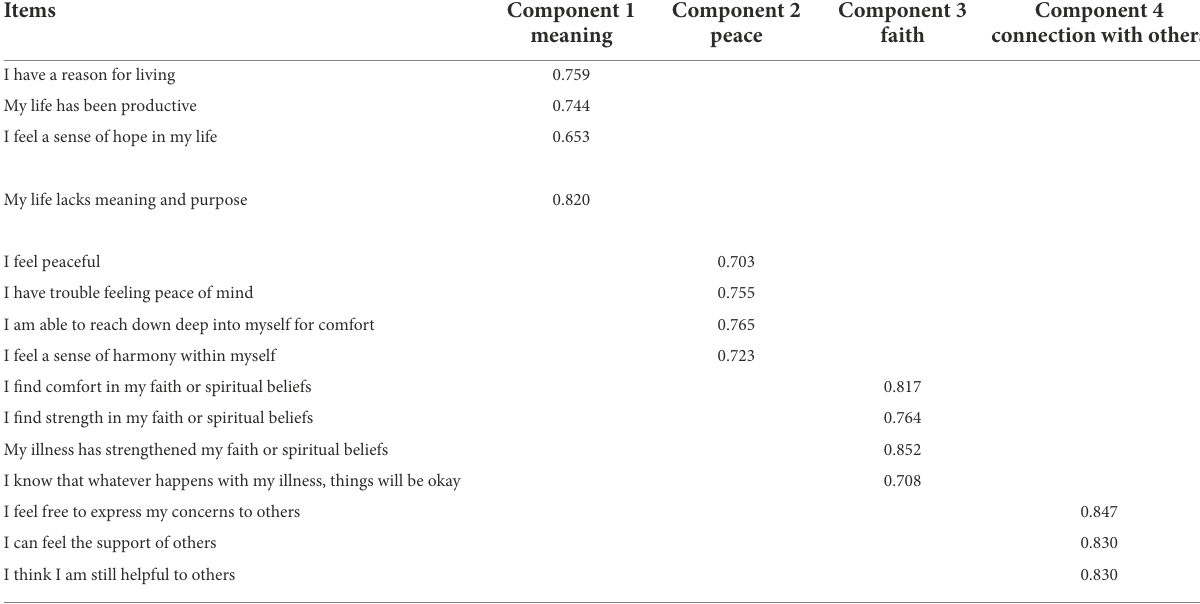
TABLE 2 Exploratory factor analysis of the 15-item FACIT-Sp scale ( n = 206). Items